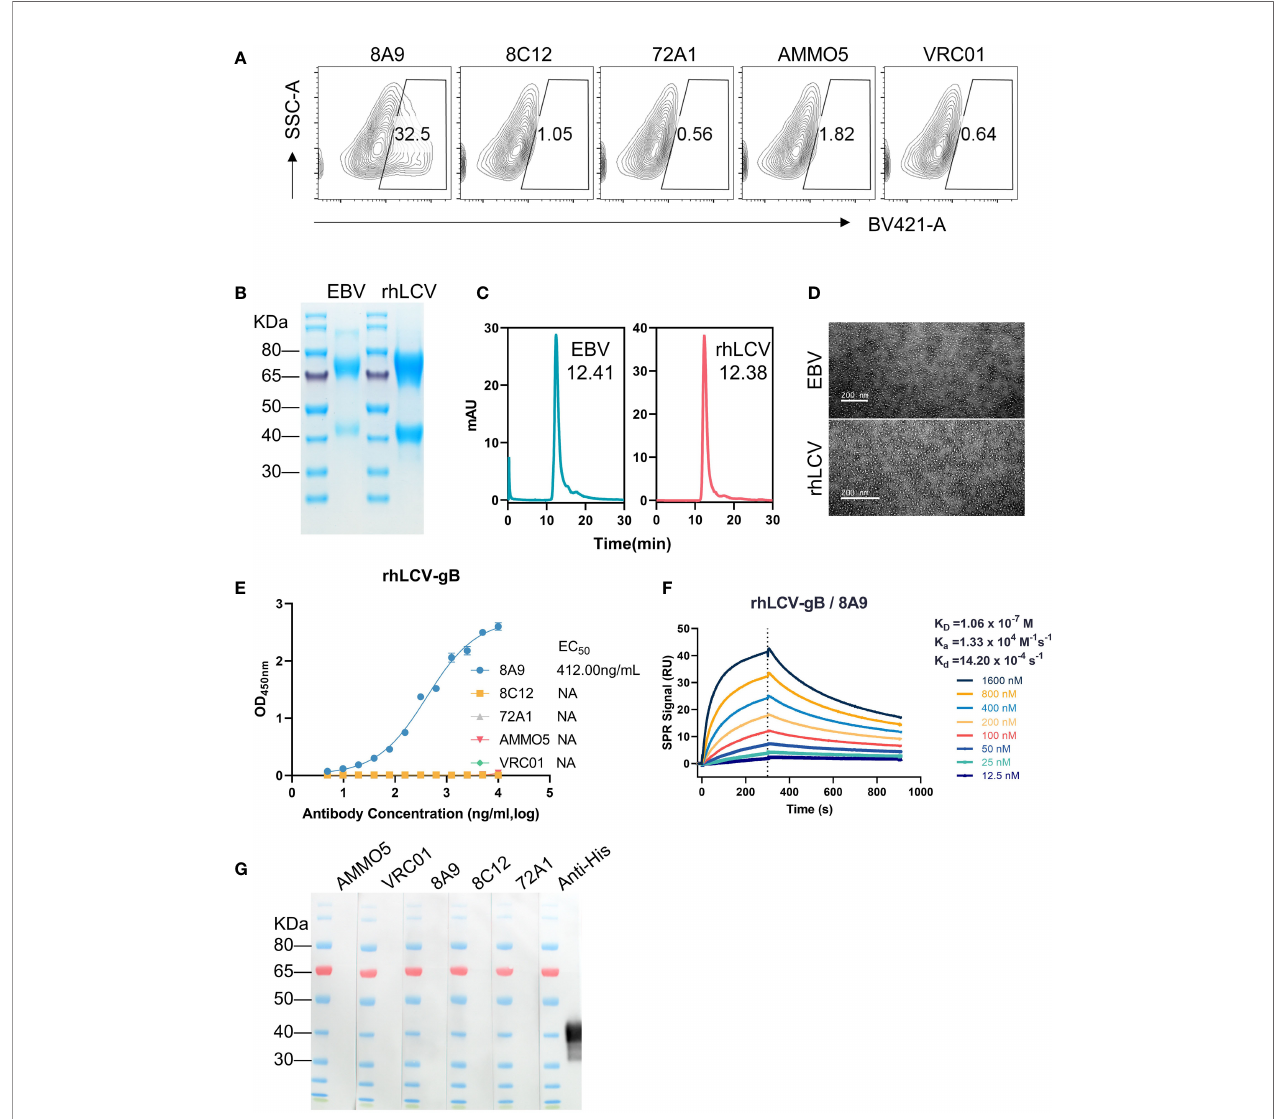
FIGURE 3 | Evaluation of the antibody cross-reactivity with rhLCV gB. (A) Evaluation of cross-reactivities of MAbs with native full-length rhLCV gB expressed in 293T cells. The stained cells were analyzed using fl ow cytometry. (B) The SDS-PAGE result of EBV gB and rhLCV gB under reducing conditions. (C, D) The size and morphology of gB proteins were evaluated by (C) high-performance liquid chromatography (HPSEC) and (D) transmission electron microscopy (TEM). (C) The retention time was calculated and marked. (E) The binding abilities of MAbs with rhLCV gB were measured using ELISA. (F) The binding af fi nity of 8A9 with rhLCV gB was evaluated using the SPR assay. (G) Western blot analysis of MAbs with denatured rhLCV